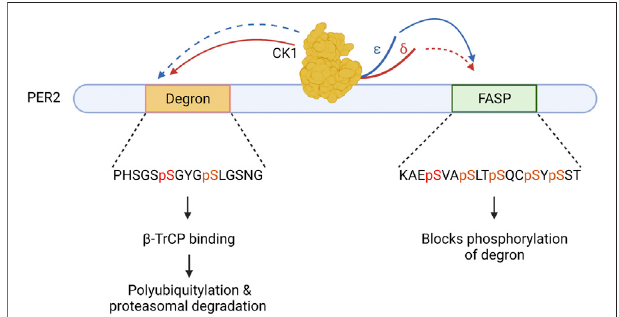
FIGURE 2 | The Circadian Phosphoswitch. CK1 phosphorylation of the PER2 degron results in B-TrCP mediated polyubiquitylation, marking it for degradation by the proteasome. CK1 phosphorylation of the FASP domain stabilizes PER2 by blocking degron phosphorylation. CK1 δ (red) and CK1 ε (blue) have different preferences for these domains due to non-identical regulatory C-terminal tails. CK1 ε displays stronger kinase activity (solid arrow) on the FASP and a weaker kinase activity (dotted arrow) on the degron as compared to CK1 δ